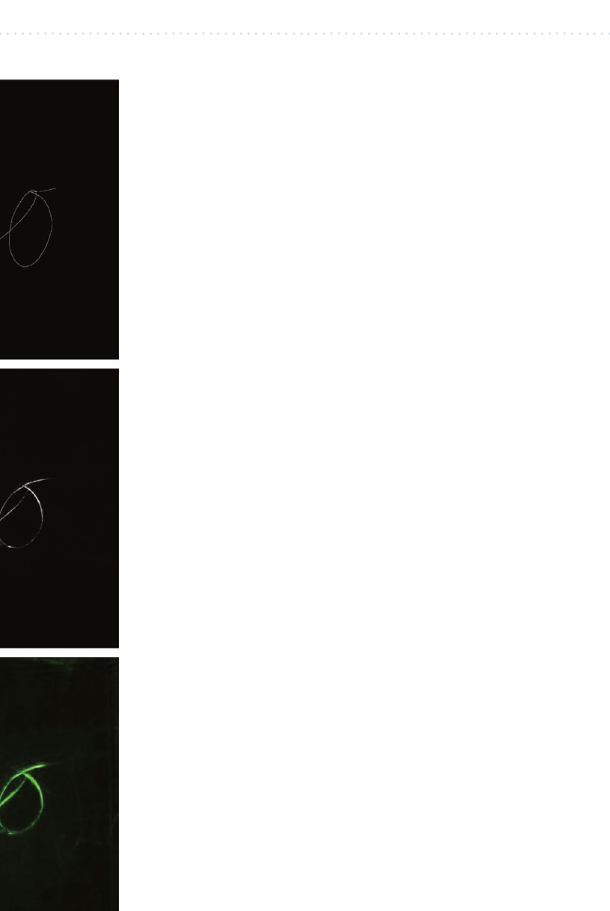
Figure 7. Examples of the reconstructed images. Left columns: numerical simulations. Right columns: optical experiments.